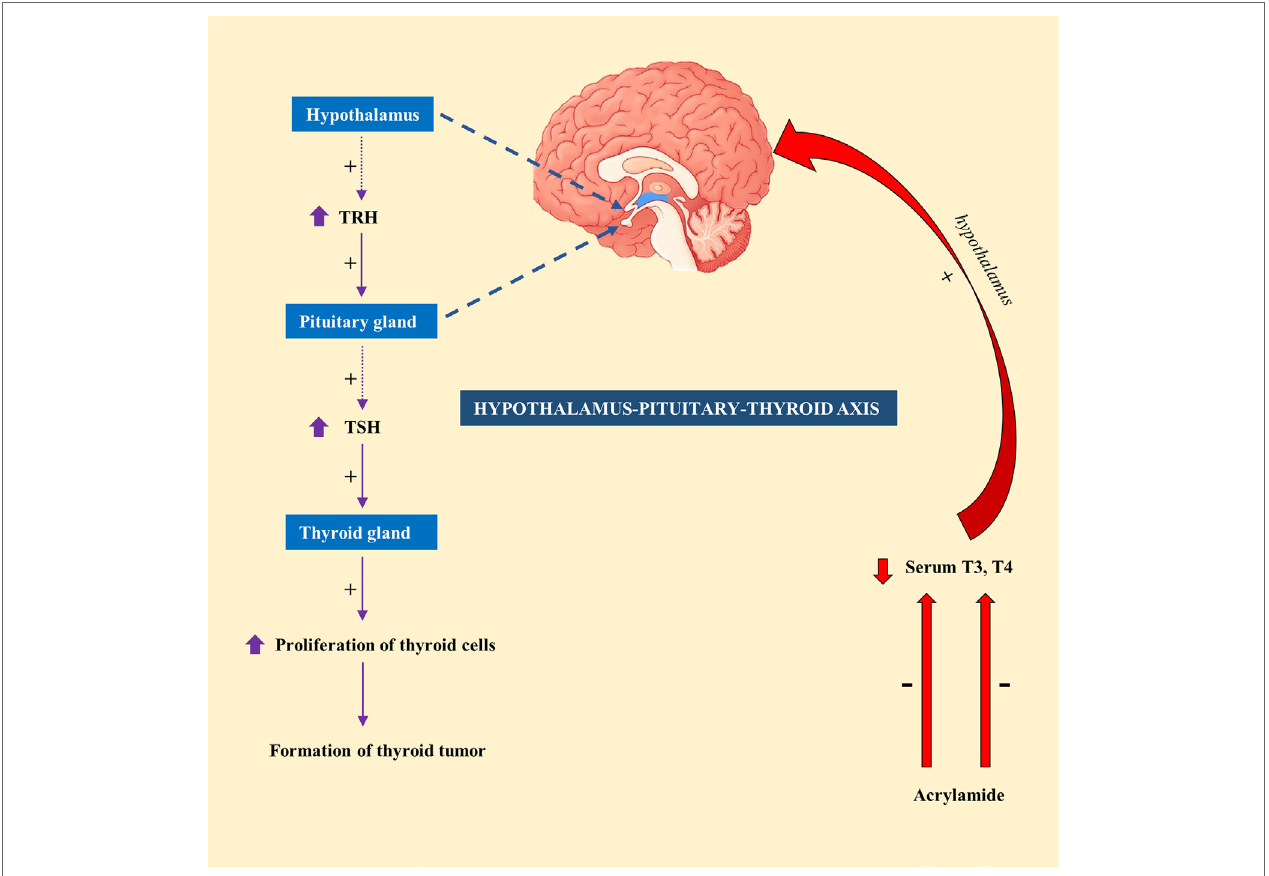
FiGURe 1 | A schematic representation showing the mechanism of action of acrylamide (AA) in thyroid tumor in rats. Exposure to AA reduces serum T3 and T4, which stimulate hypothalamus of hypothalamus-pituitary-thyroid axis to secrete thyrotropin-releasing hormone (TRH). TRH stimulates pituitary gland to release thyroid-stimulating hormone (TSH), which subsequently stimulate thyroid gland to initiate proliferation of cells and eventually development of thyroid